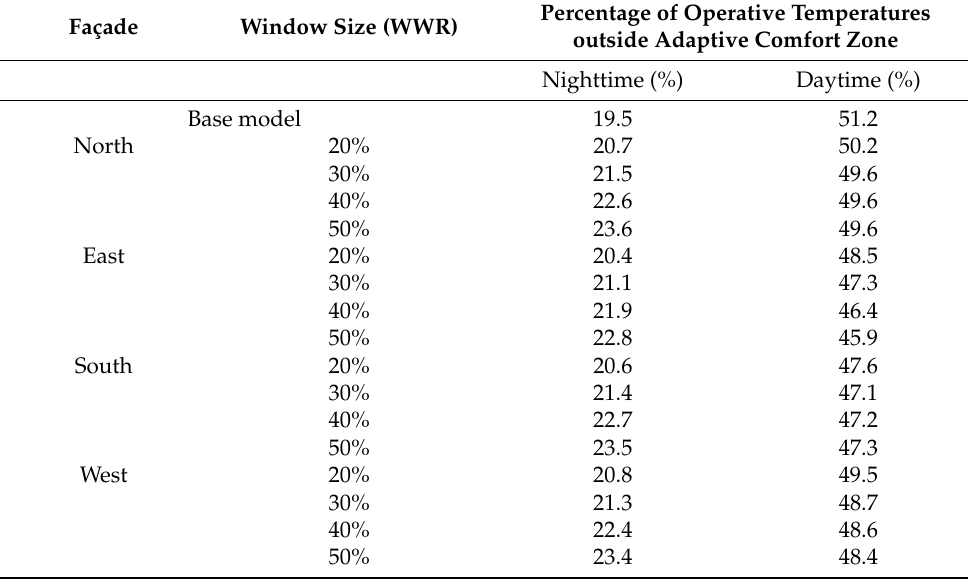
Table 3. Effects of window size on thermal performance of the base model.